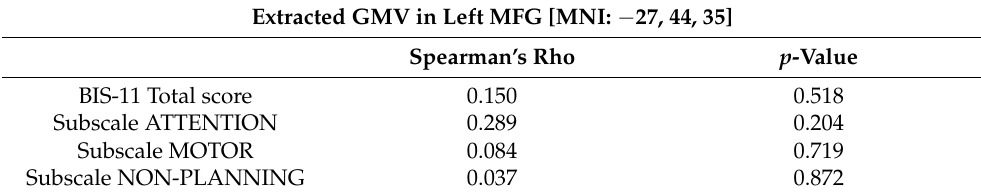
Table A2. BE group: Correlations between BIS-11 and GMV in the left MFG.